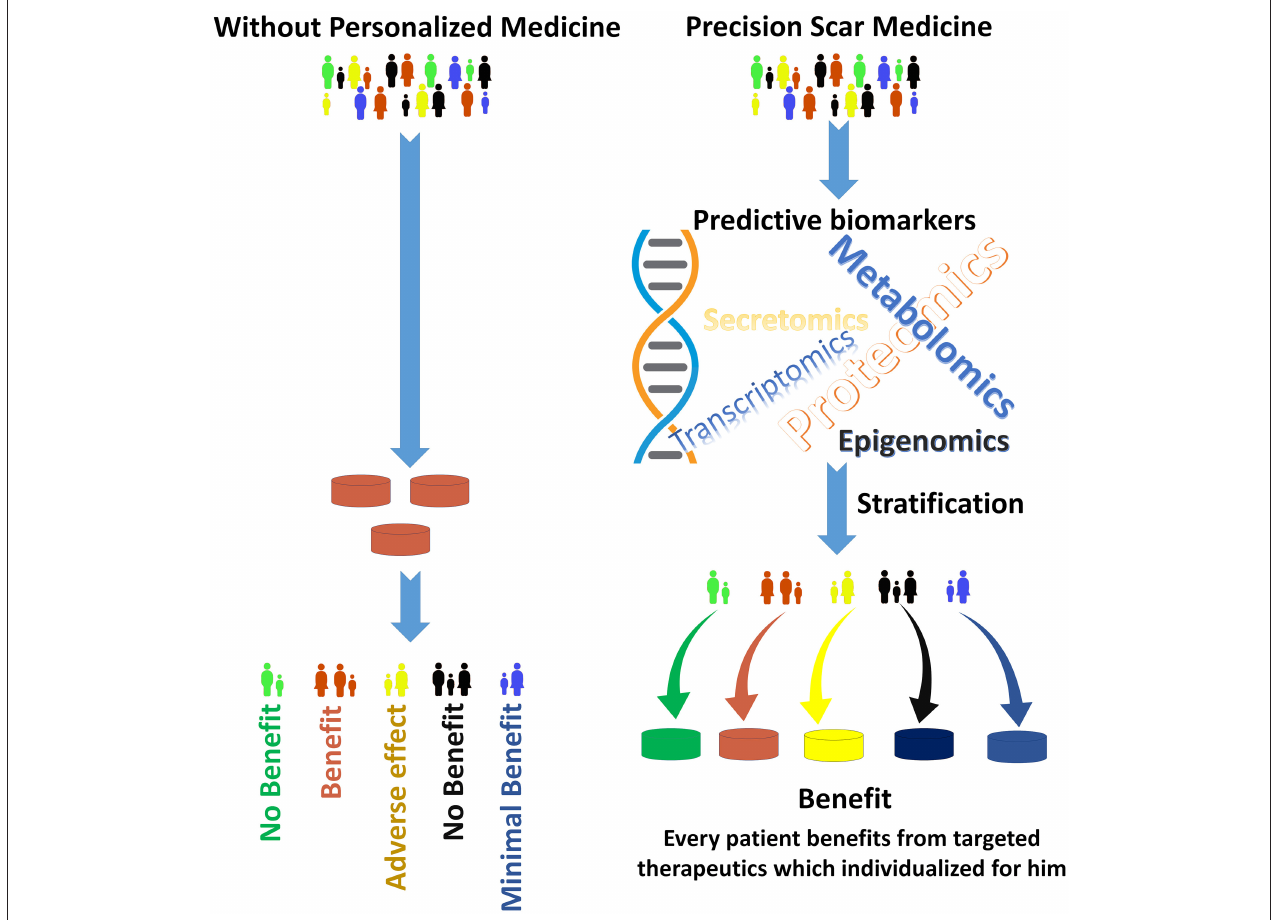
FIGURE 1 | The goal of Precision Scar Medicine is to treat each patient with the best possible therapeutics. Patients with skin injuries often have different outcomes. The precision scar medicine approach provides tools to classify patients with skin injury into delicate subclasses by biomarkers that may predict responses to a particular therapeutics. Without personalized medicine (Left) , a “green patient” may receive brown medications which have no benefit in his scar management. Conversely, the “green patient” in the right will receive green therapeutics (that is, his biomarkers are associated with the best outcome with green medication) which has the maximal effect on scar prevention/management for this specific patient. The stratification methods derived from the integration of large amounts of data to find individualizing biomarkers. Additionally, this stratification may be used for the patient before elective surgeries to provide personalized preventive approaches to prevent and manage skin